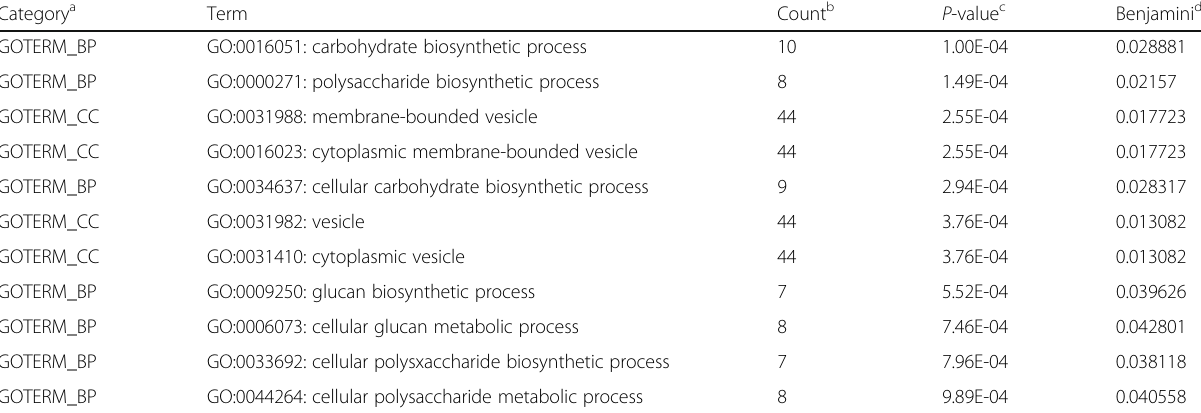
Table 1 GO enrichment in DEGs between Dongjin plants and sui4 mutants Category a Term Count b P -value